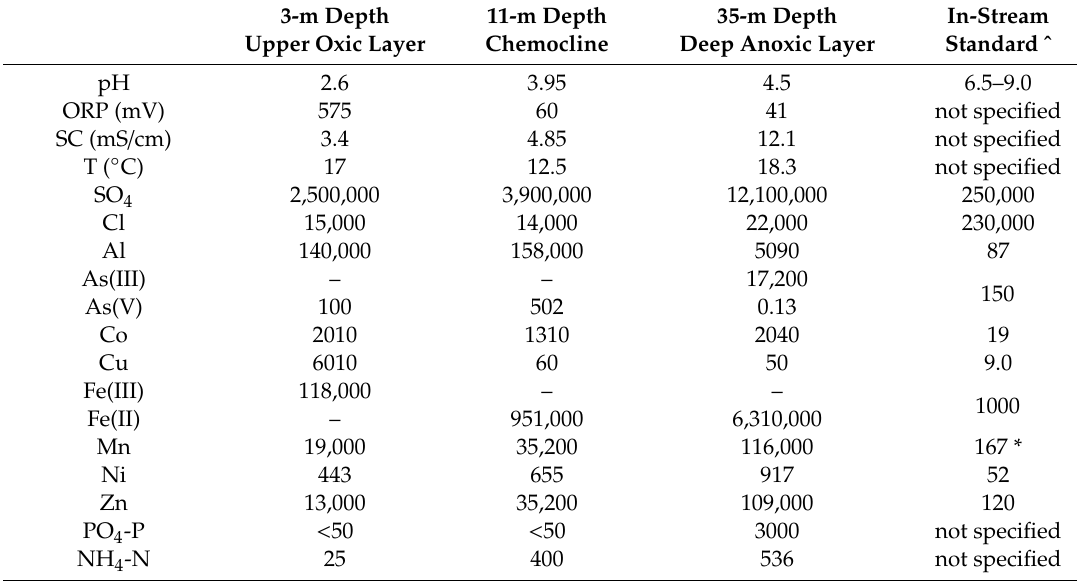
ˆ USEPA National Ambient Water Quality Criteria—Constant Contact Concentration Factor. * Mn standard calculated as (Fe standard / 6) corresponding to concentration ratio of USEPA drinking water standards. – refers to species not predicted by geochemical